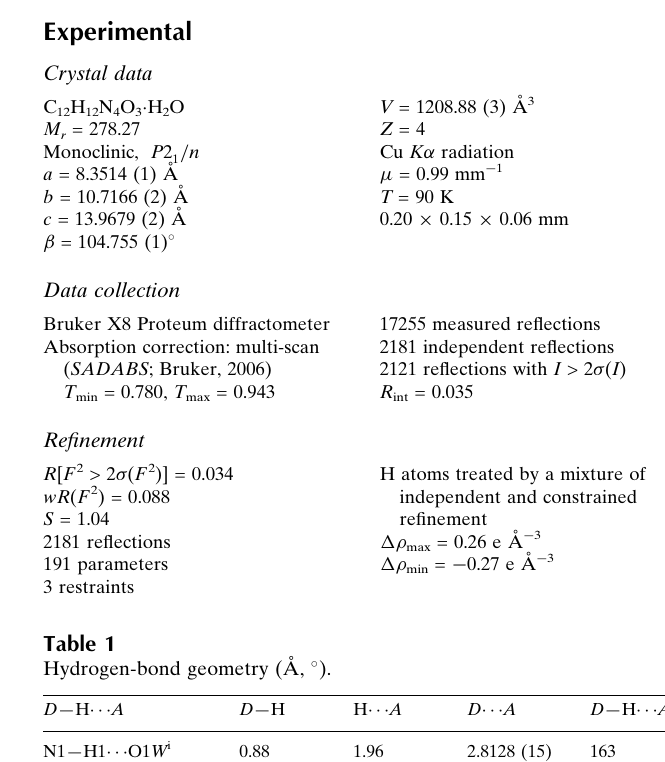
Bruker X8 Proteum diffractometer Absorption correction: multi-scan